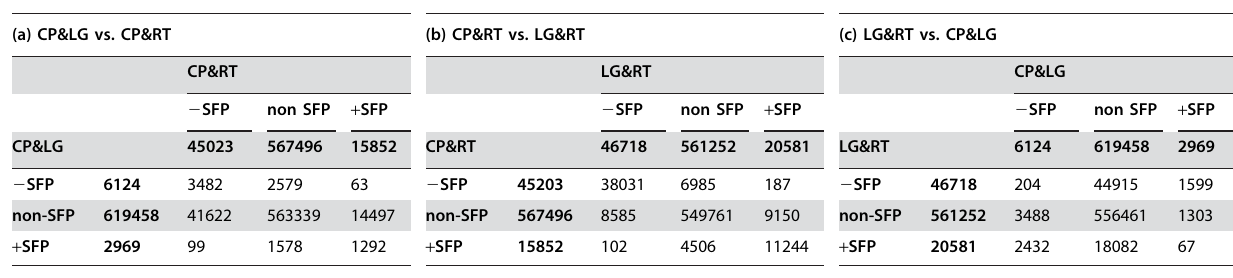
Table 5. Overlapping SFPs among gene-chip experiments datasets. .. ... .... ... ... .... ... ... .... ... ... .... ... ... .... ... ... .... ... ... .... ... ... .... ... ... .... ... ... .... ... ... .... ... ... .... ... ... .... ... ... .... ... ... .